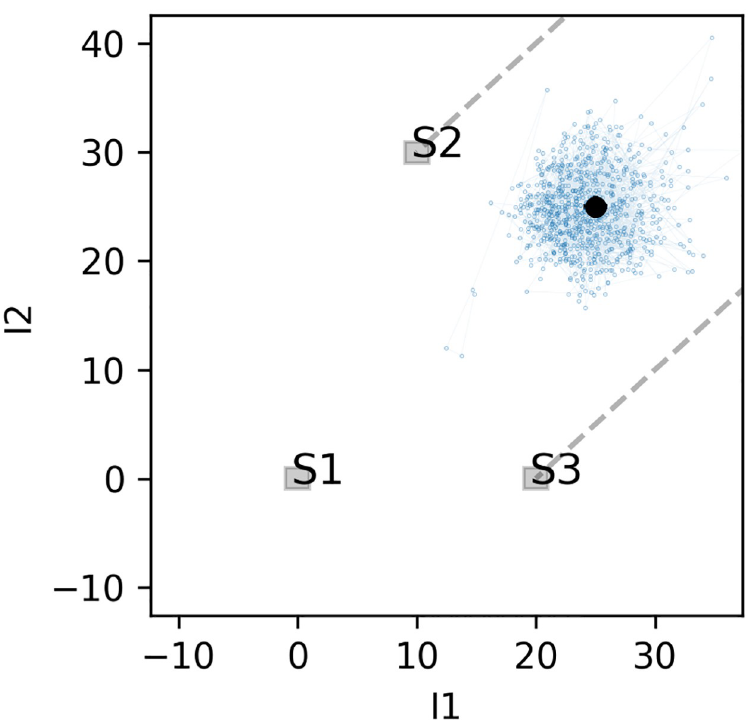
Fig 6. Simulation of 2D mixing and fractionation—the sources S 1 , S 2 and S 3 are pictured with grey rectangles and dashed lines show the direction and boundaries related to the fractionation process. The measured sample is represented by a black circle and blue dots show consecutive configurations accepted by the MCMC algorithm plotted in a I 1 - I 2